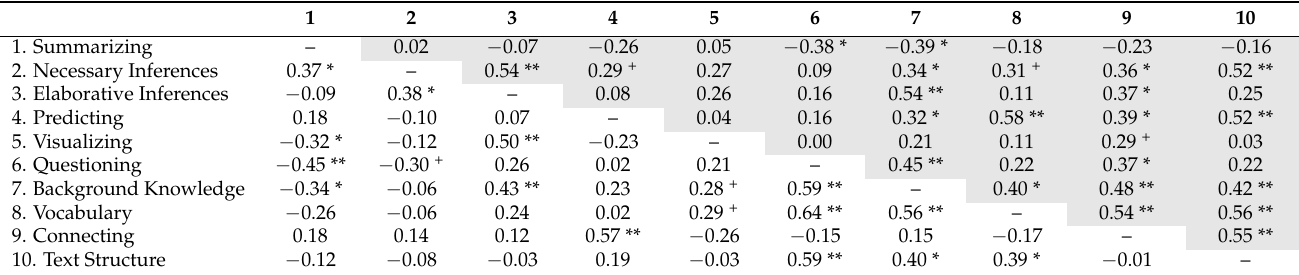
Table 4. Correlations between Strategy Types for Both English (Unshaded) and French (Shaded).